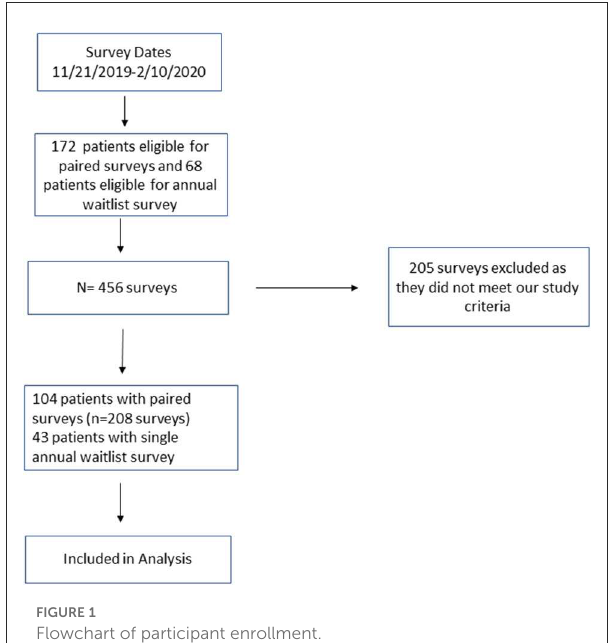
FIGURE1 Flowchart of participant